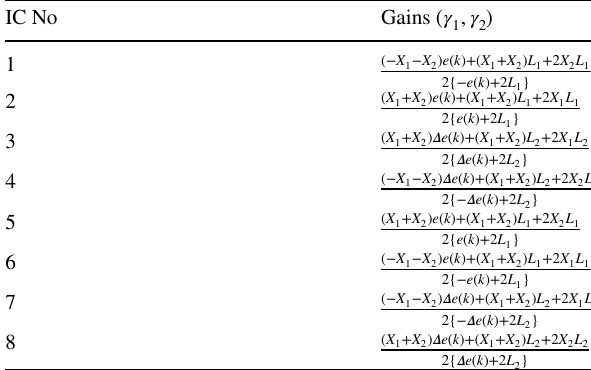
Table 4 Expressions of gains with 𝜃 1 = 𝜃 2 =